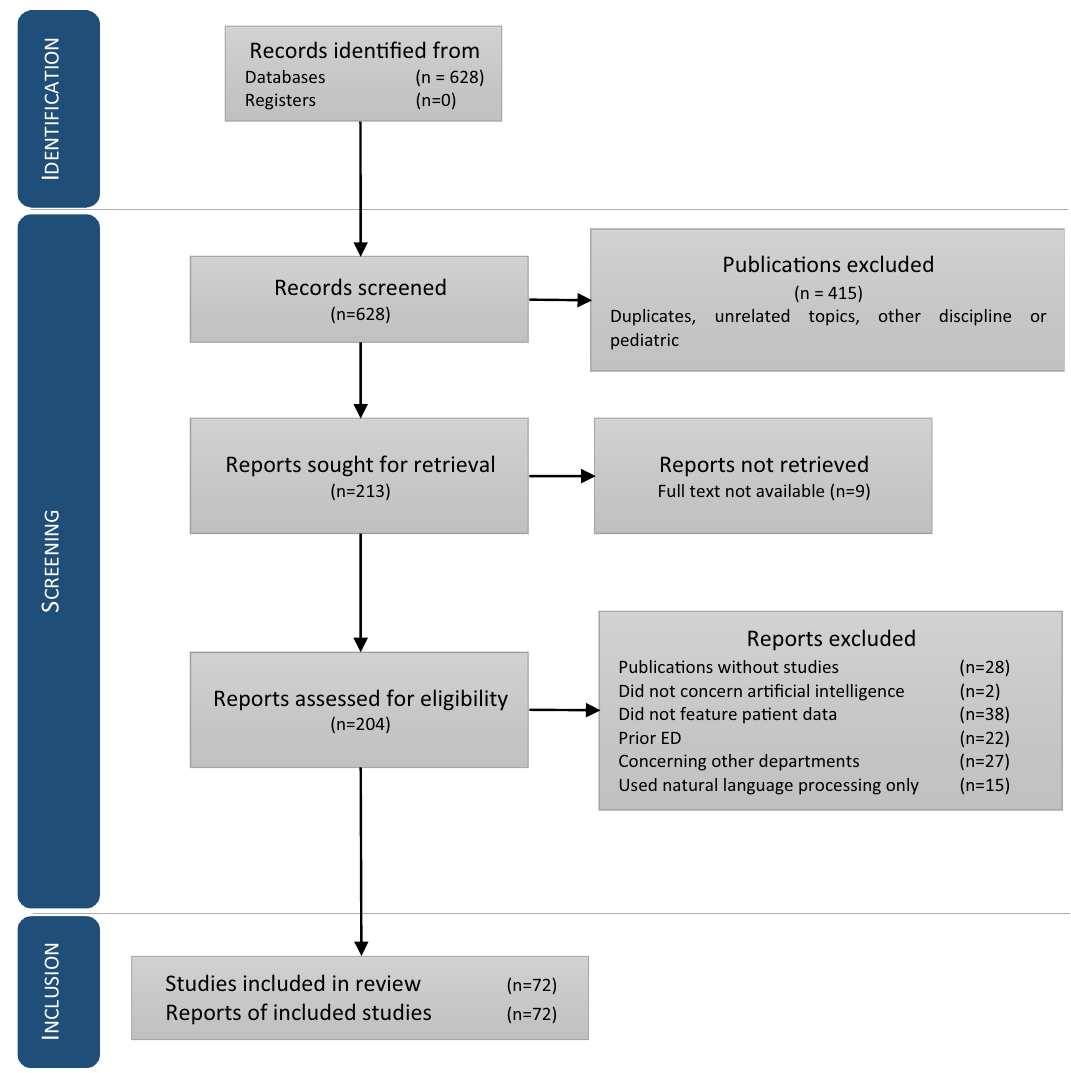
Fig. 2 Identi fi cation, screening and inclusion of studies via databases and